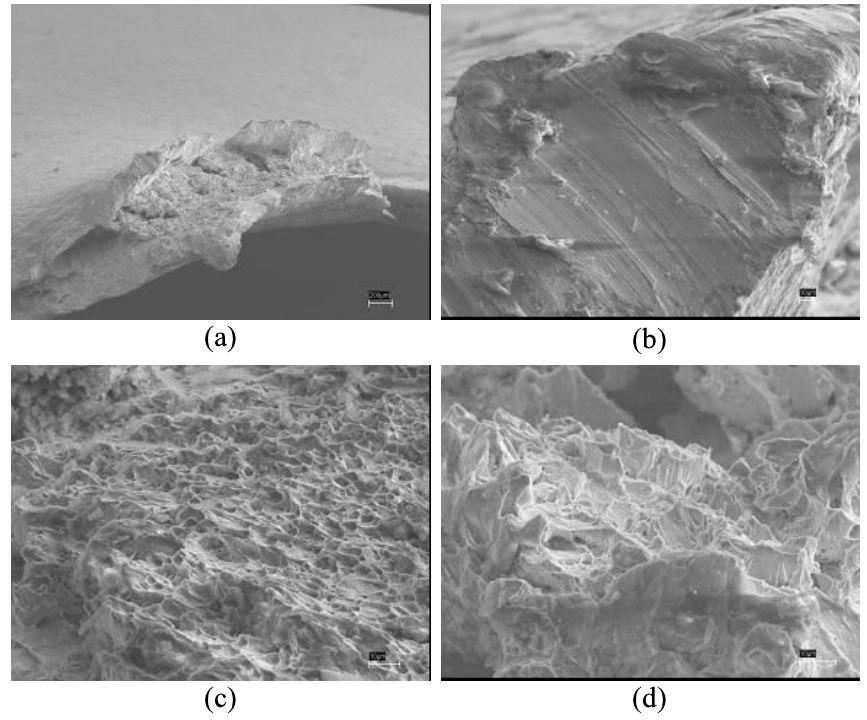
Fig. 7. Fracture surfaces from a plate displaying local holing and petaling damage: a) delamination, b) rubbing, c) ductile shear, and d) quasi cleavage.